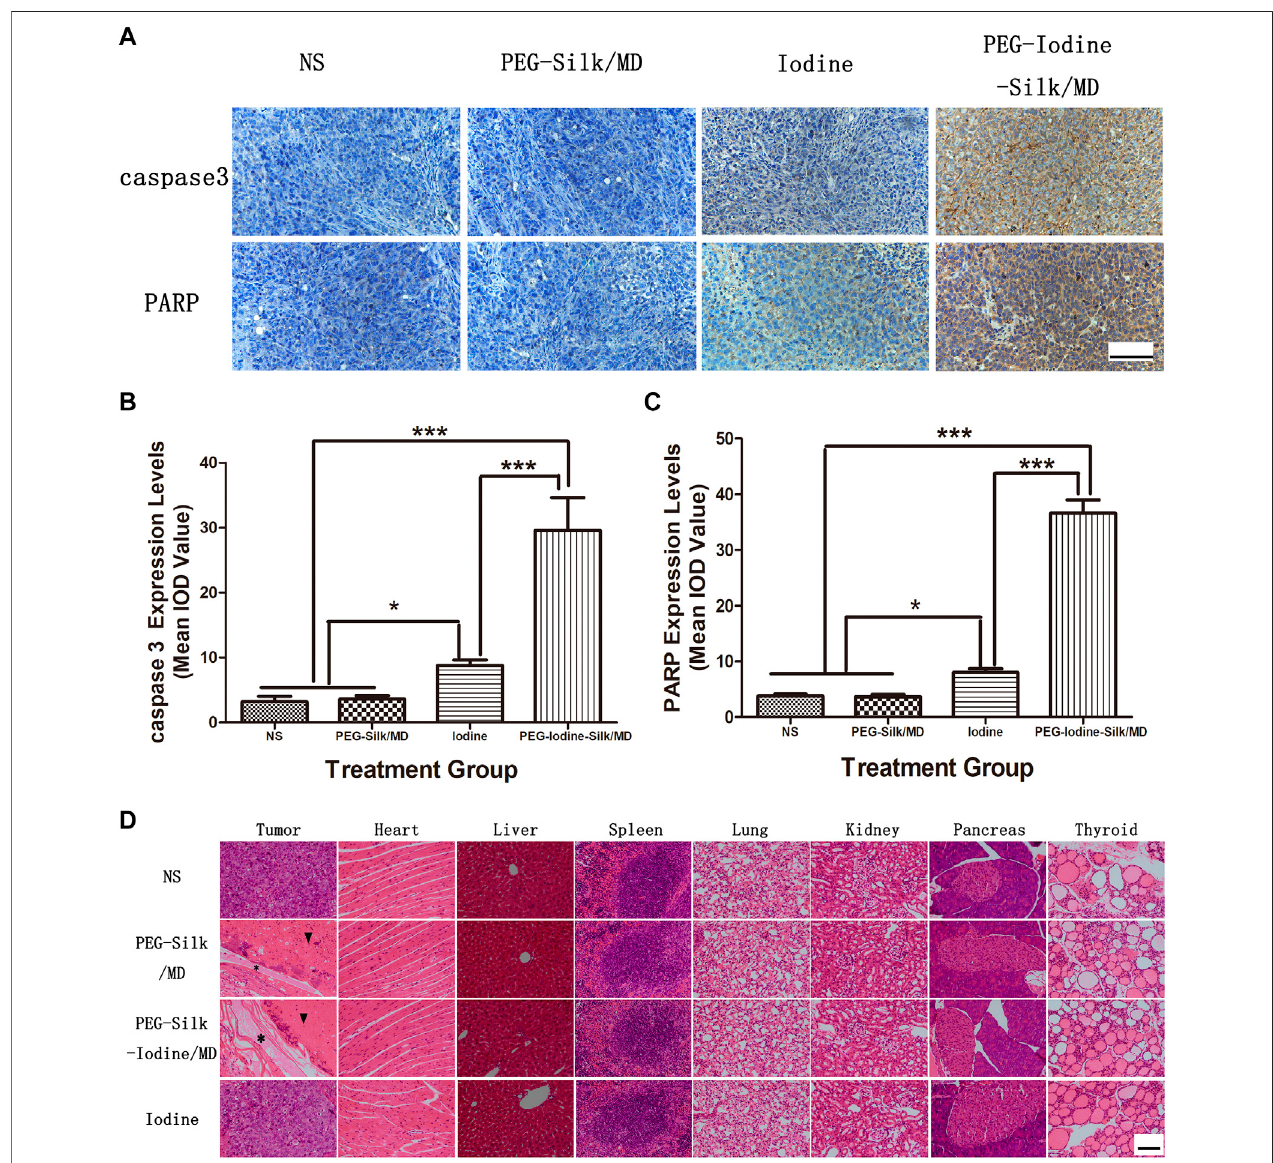
FIGURE 7 | Immunohistochemical and H&E staining. (A) Caspase-3 and PARP expression in OS sections from the different groups was characterized by immunohistochemistry. Thedataarerepresentativeimages(scalebars=100 µm). (B) Quanti fi cationofthecaspase-3stainingdensities.Thedataexpressedasthemean± SD of in individual groups of OSs ( n = 5) ( *p < 0.05, ***p < 0.001). (C) Quanti fi cation of the PARP staining densities. The data are expressed as the mean ± SD of individual groupsofOSs( n =5)(* p < 0.05,*** p < 0.001). (D) OSsandmainorgans(heart,liver,spleen,lung,kidney,pancreasandthyroid)weredissectedforH&Estainingonthe 42nd day after injection. No signi fi cant abnormal damage was observed in the organs. * indicates silk hydrogel. ▼ indicates necrotic OS tissue (scale bars = 100 µm). (OS, osteosarcoma; PEG, polyethylene glycol; MD, meglumine diatrizoate; SD, standard deviation; H&E, haematoxylin and eosin; IOD, integrated optical density).